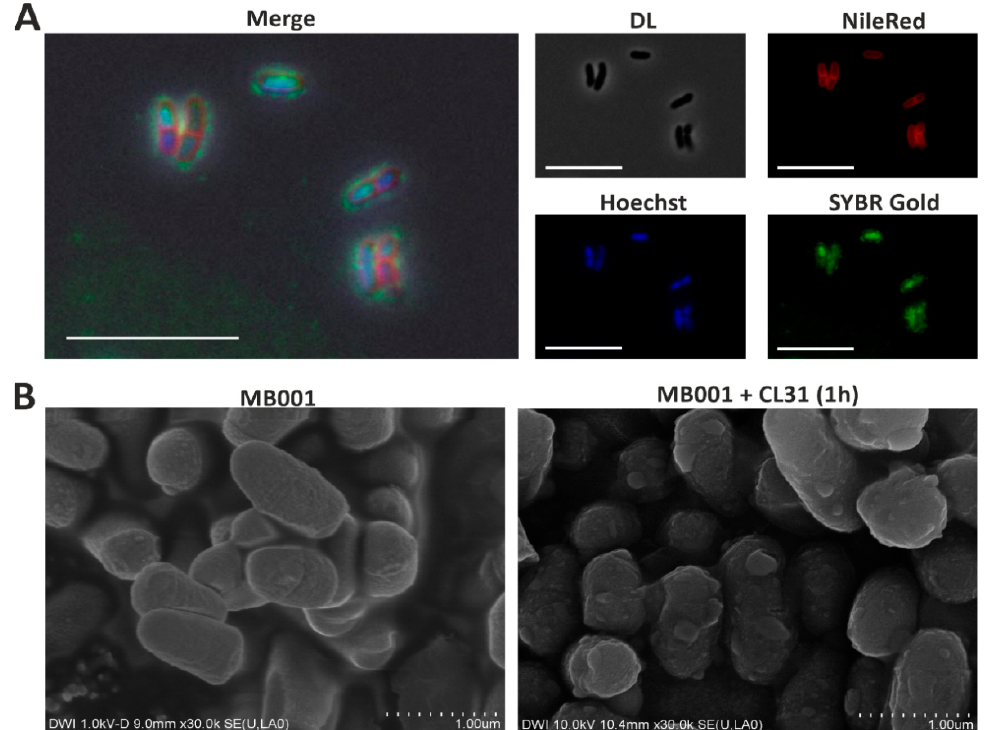
Figure 3. Visualization of CL31 attachment and host lysis. ( A ) Fluorescence microscopy of C. glutamicum MB001 cells stained with Nile red and Hoechst 33342, mixed with SYBR Gold stained CL31 phages. The bacterial cells and phages were mixed with a high MOI (~100) and directly analyzed using a Zeiss M2 imager fluorescence microscope. ( B ) Scanning electron microscopy images taken from C. glutamicum MB001 cells without (top) and with (bottom) CL31 phages. Bacterial cells and phages were mixed with an MOI of 1.2 and incubated for 1 h at 30 °C and 120 rpm in BHI medium.